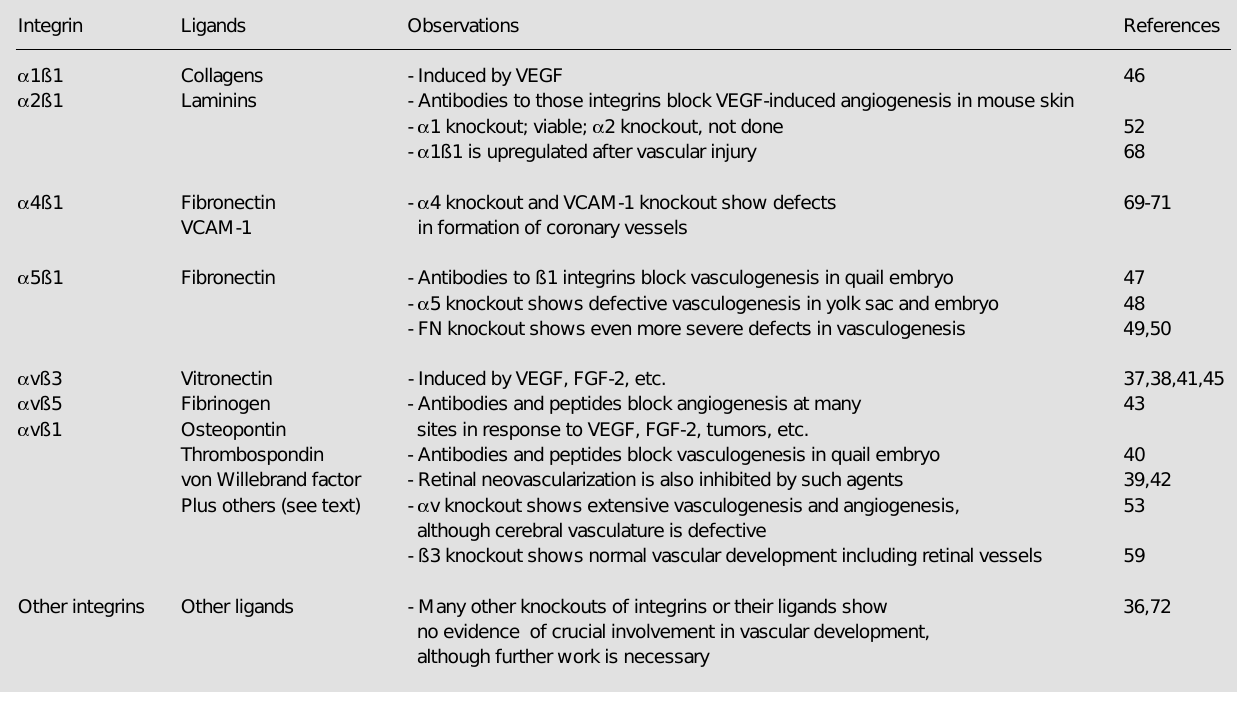
Table 1 - Integrins and their ligands in vascular development. VEGF, Vascular endothelial growth factor; FGF-2, basic fibroblast growth factor; VCAM-1, vascular cell adhesion molecule. Integrin Ligands